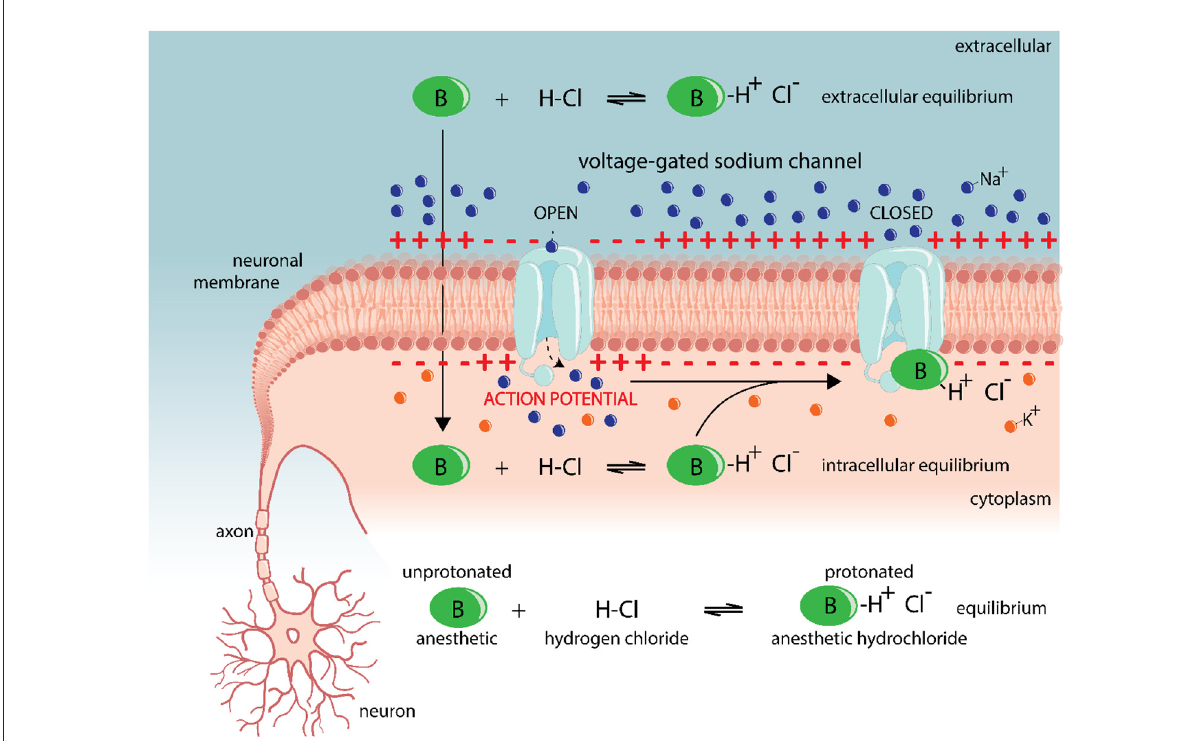
FIGURE1 Mechanism of local anesthetics on voltage-gated sodium channels in neuronal cell membrane. Local anesthetics (green) pass through the cell membrane and then bind on voltage-gated sodium channels (light blue) on the inside of the cell membrane and block sodium-influx (dark blue) into the cell (28). Anesthetics are usually administered as a hydrochloride salt, a protonated form (BH + Cl-) that is more water-soluble. However, the reaction is reversible and both forms, protonated and unprotonated, are in equilibrium with the relative amounts depending on the environmental pH. If the environmental pH is equal to the dissociation constant (pKa) of the anesthetic, usually between 8 < pKa < 9, both forms are present in equimolar amounts. In more basic environments like the extracellular space, the unprotonated form is favored while in